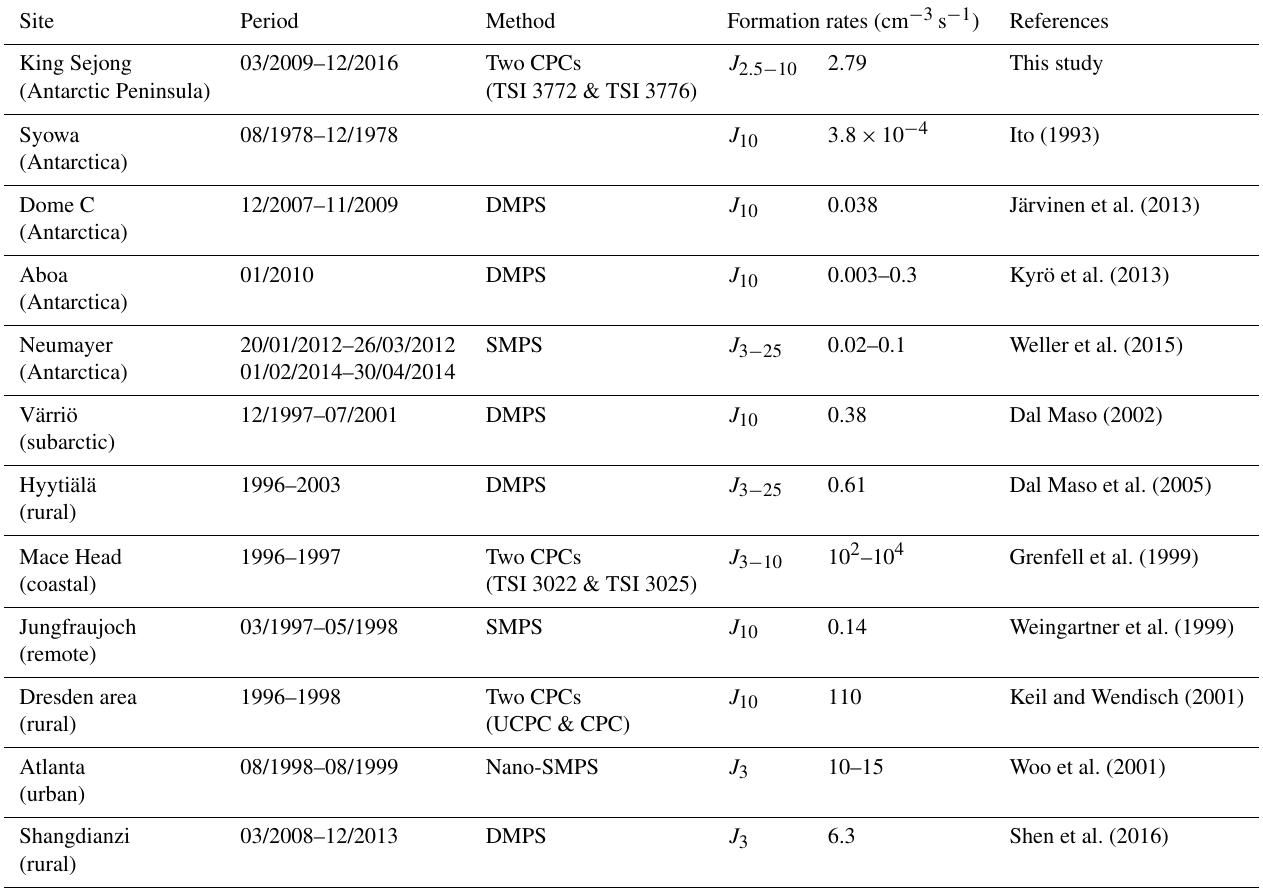
Table 3. Summary of the formation rates observed at different sampling sites in Antarctica and in other continents. DMPS, SMPS and CPC mean differential mobility particle sizer, scanning mobility particle sizer and condensation particle counter, respectively.